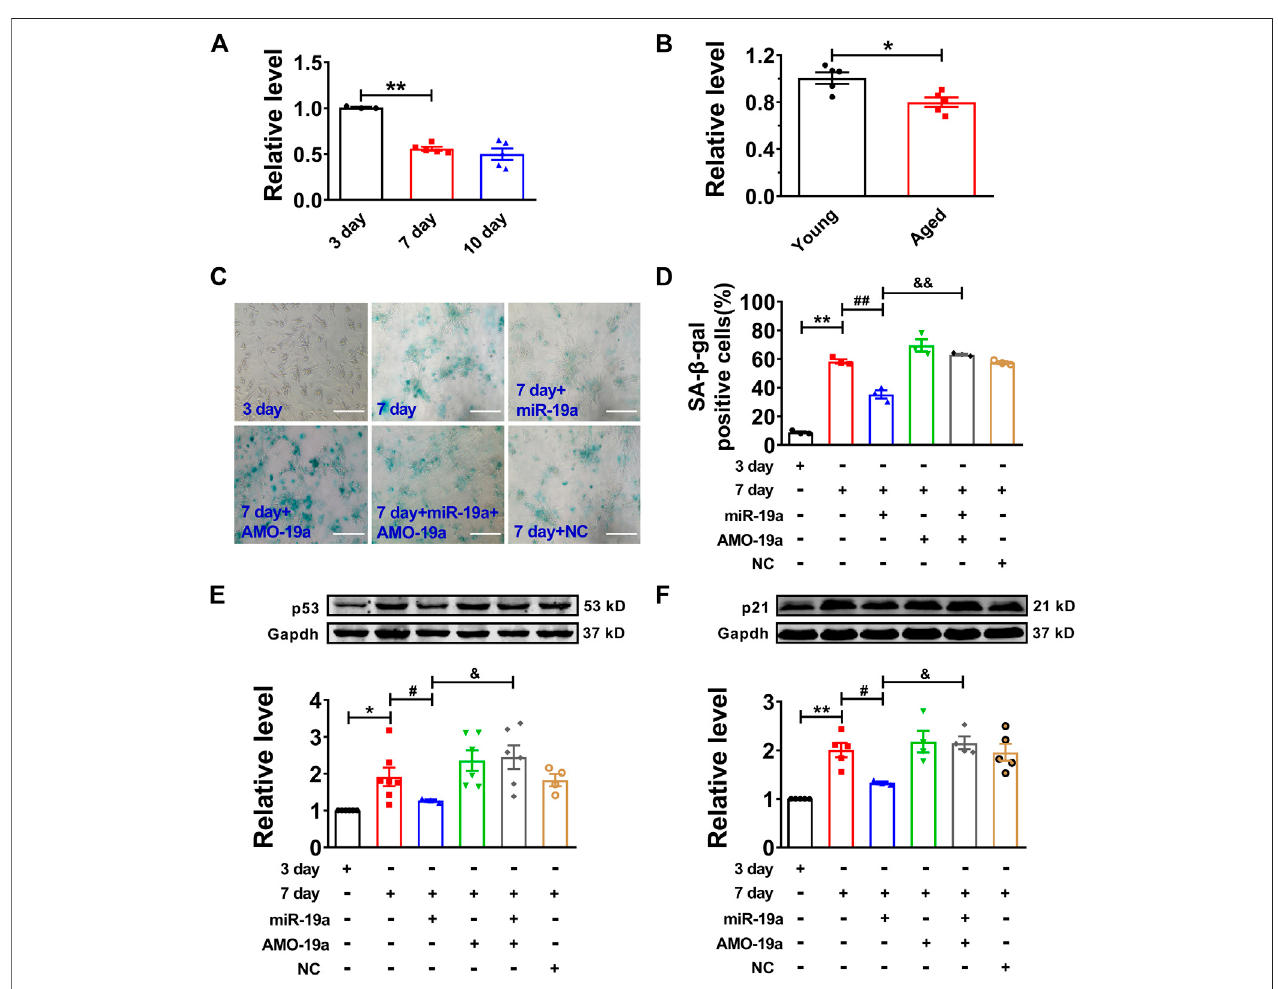
FIGURE 4 | miR-19a involved in regulation of cardiomyocyte senescence. (A) Decreased expression of miR-19a with varying exposure durations to high glucose. (B) Decreased expression of miR-19a in aged mouse hearts. (C) Representative pictures showing the inhibitory effect of miR-19a on SA- β -gal activity of senescent cardiomyocytes.Scalebars (cid:2) 50 μ m. (D) ThestatisticalresultsofSA- β -galpositivecellsindifferentgroups. (E,F) ThesuppressiveeffectofmiR-19aontheexpressionof senescence-associatedproteinp53andp21insenescentcardiomyocytes.Dataareexpressedasmean ± SEM,* p < 0.05vs.Young/3 days,** p < 0.01vs.3